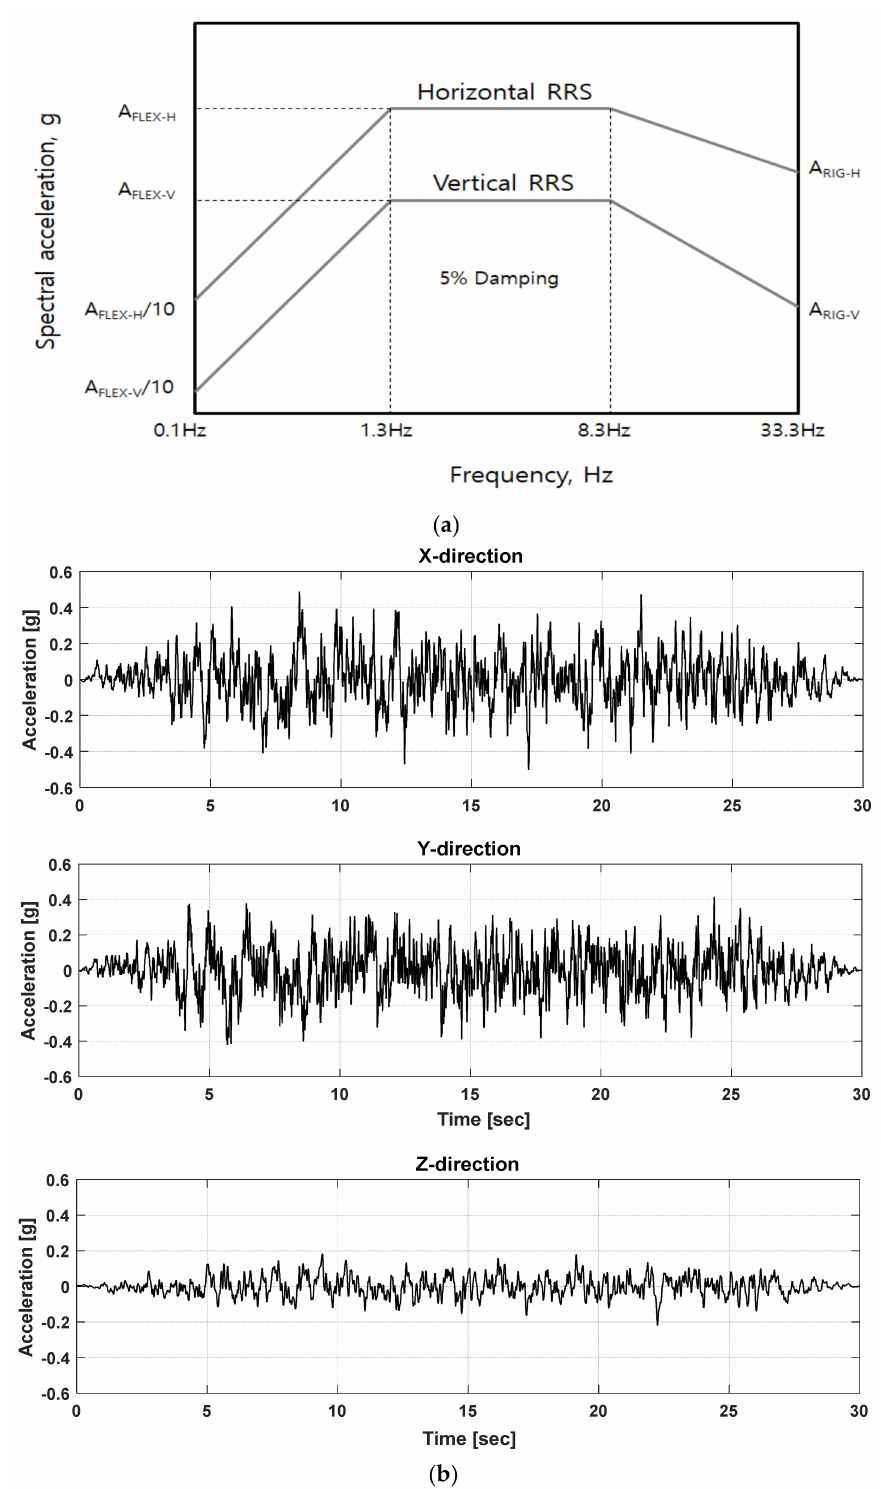
Figure 4. Input motion ( a ) RRS based on ICC—ES AC 156, ( b ) acceleration time